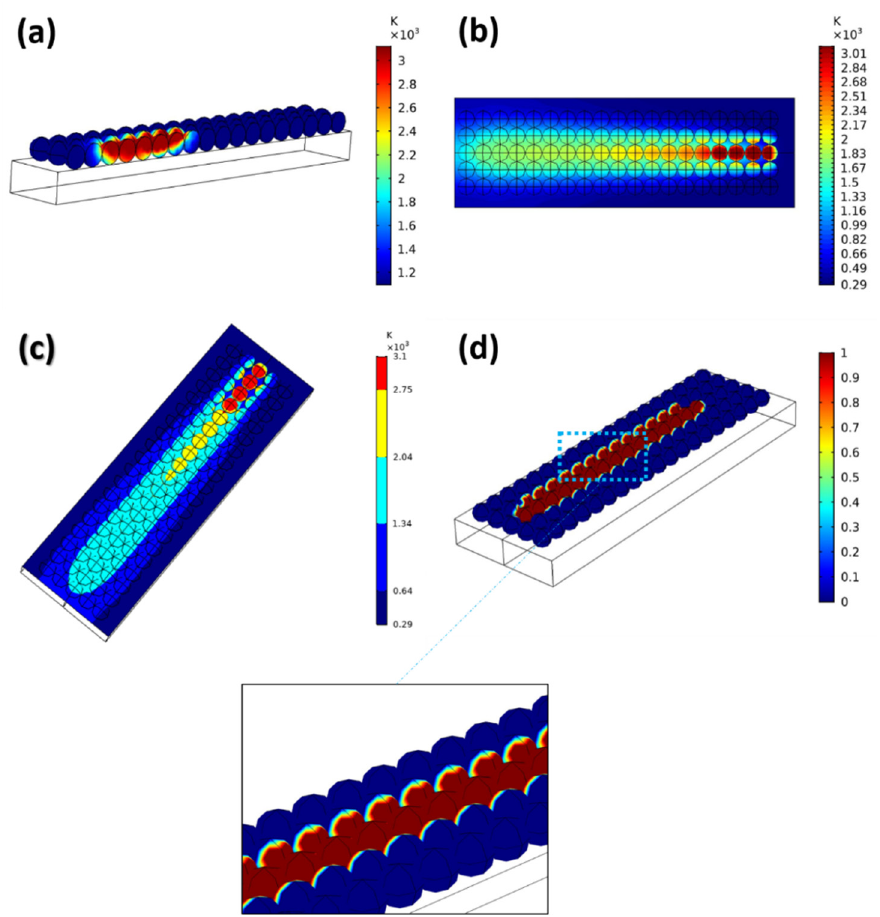
Figure 3. Three-dimensional temperature distributions using 900 mm/s scanning velocity, 150 W laser power, and 50 μm laser spot diameter: ( a ) symmetry view, ( b ) complete view, ( c ) and isosurface view showing the zones with various temperature values at the moment. ( d ) Phase change from solid phase (0) to liquid phase (1).